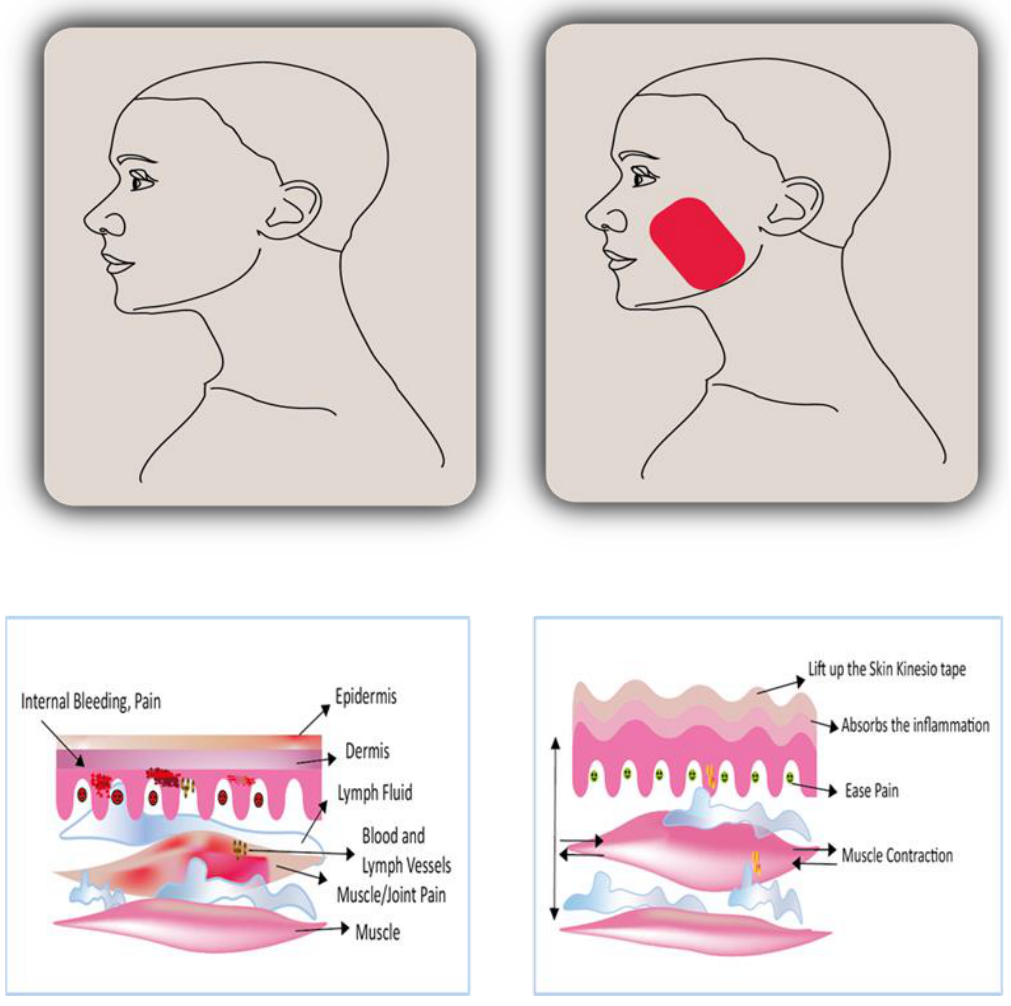
Figure 1. These two images demonstrated how KT is applied to soft tissue and its mechanism. The lesion site, such as a taut band or bruise, may have bleeding, pressure, and lymph fluid build-up which will then cause pain before taping. The fluid drainage is aided by the space-lifting mechanism after taping as shown. The muscles’ ability to move will then be enhanced as the pressure and inflammatory factors are decreased [29].